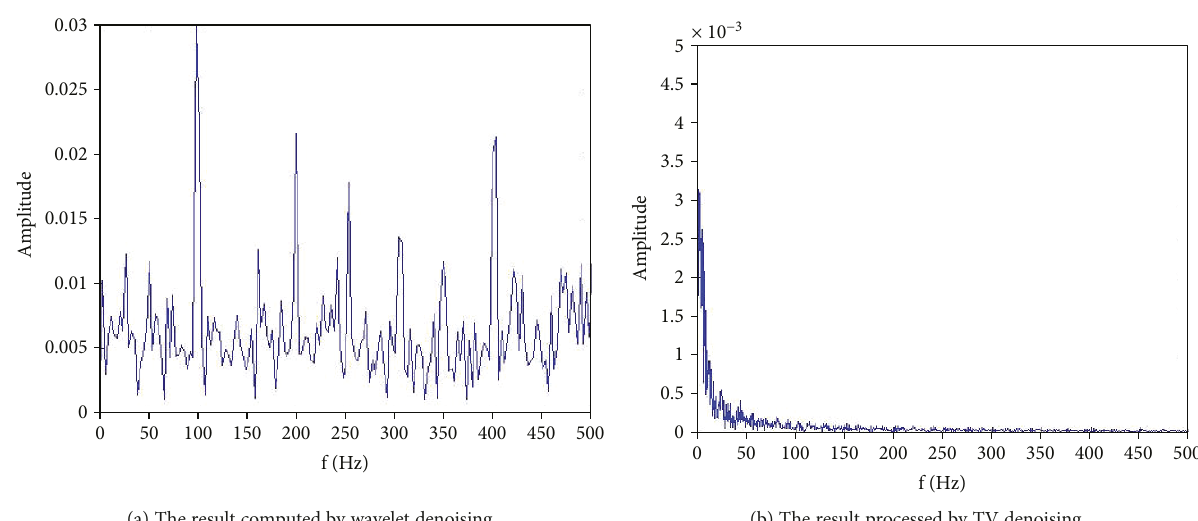
Figure 10: The result provided by wavelet denoising and TV